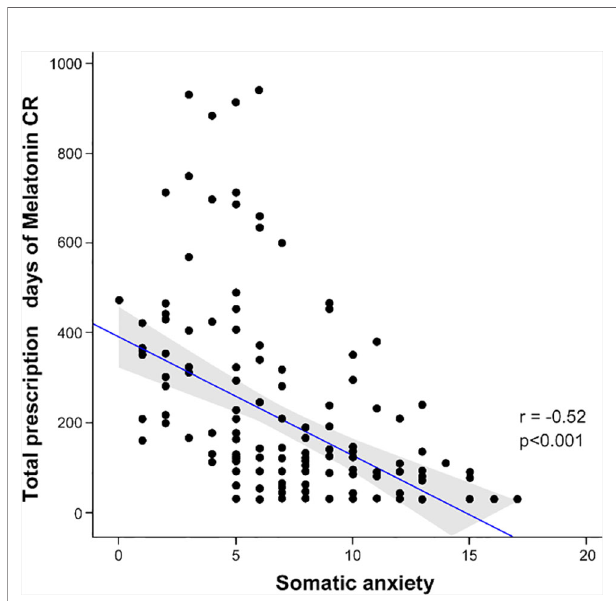
FIGURE 1 | Scatterplot showing the correlation between total prescription days of melatonin CR and somatic anxiety score (Spearman correlation r = - 0.52, p < 0.001).